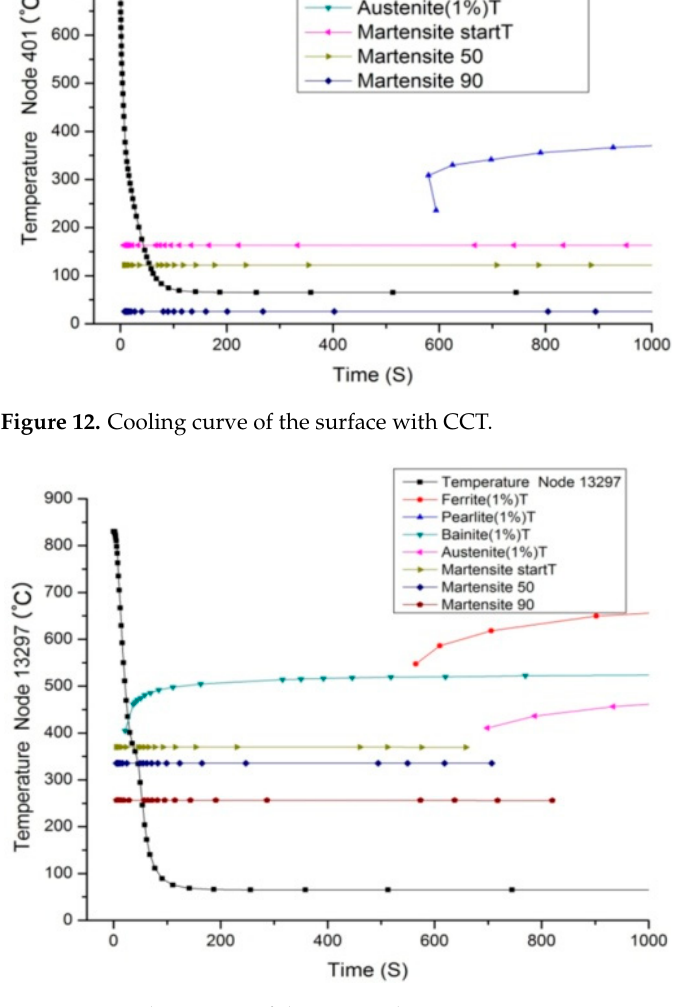
Figure 13. Cooling curve of the core with CCT.